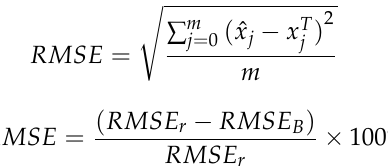
Figure 4. Kp and Dst indices during the experimental time on 16 − 25 June 2015.